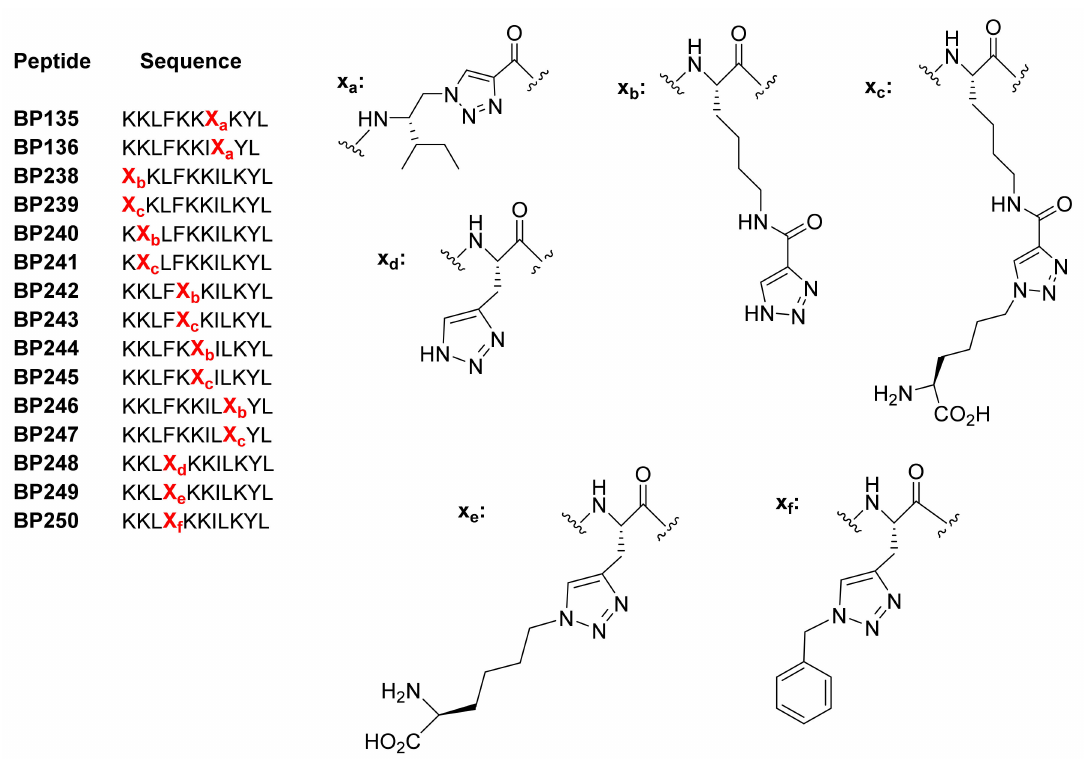
Figure 3. Structure of BP100 peptide sequence